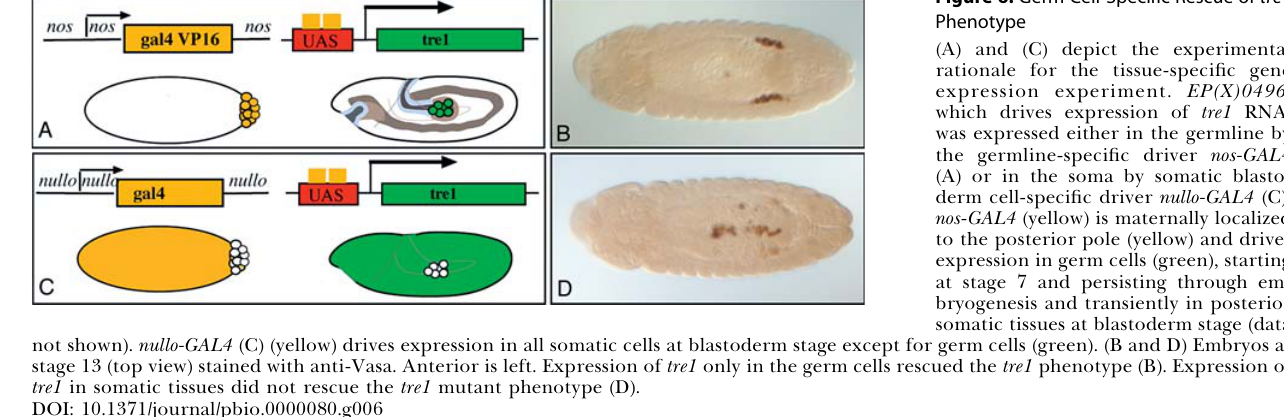
Figure 6. Germ Cell-Specific Rescue of tre1 Phenotype (A) and (C) depict the experimental rationale for the tissue-specific gene